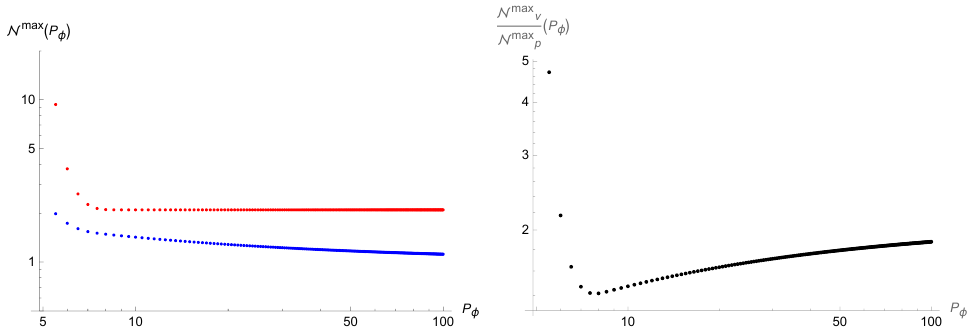
Figure 2. Number of particles as function of time φ (Ashtekar variables in blue, volume variables in red) for two different values of the initial condition ( P φ = 4.5 on the left , P φ = 5.5 on the right ).